Question: Author a descriptive caption for the visualization shown.
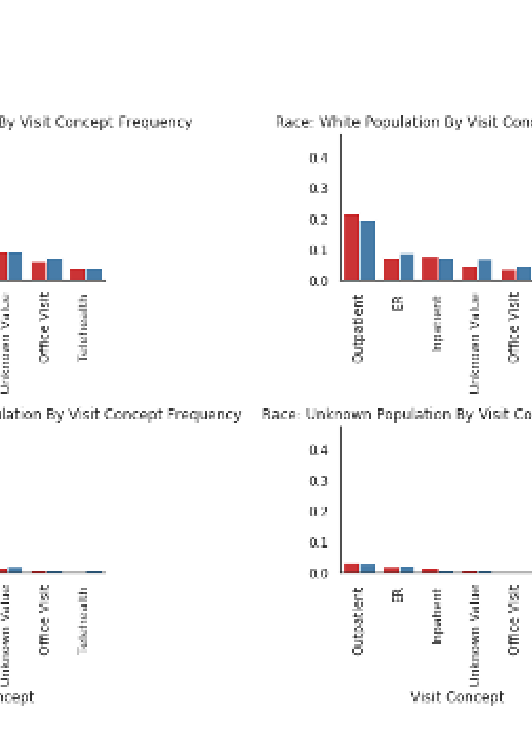
Answer: The visit prevalence stratified by race